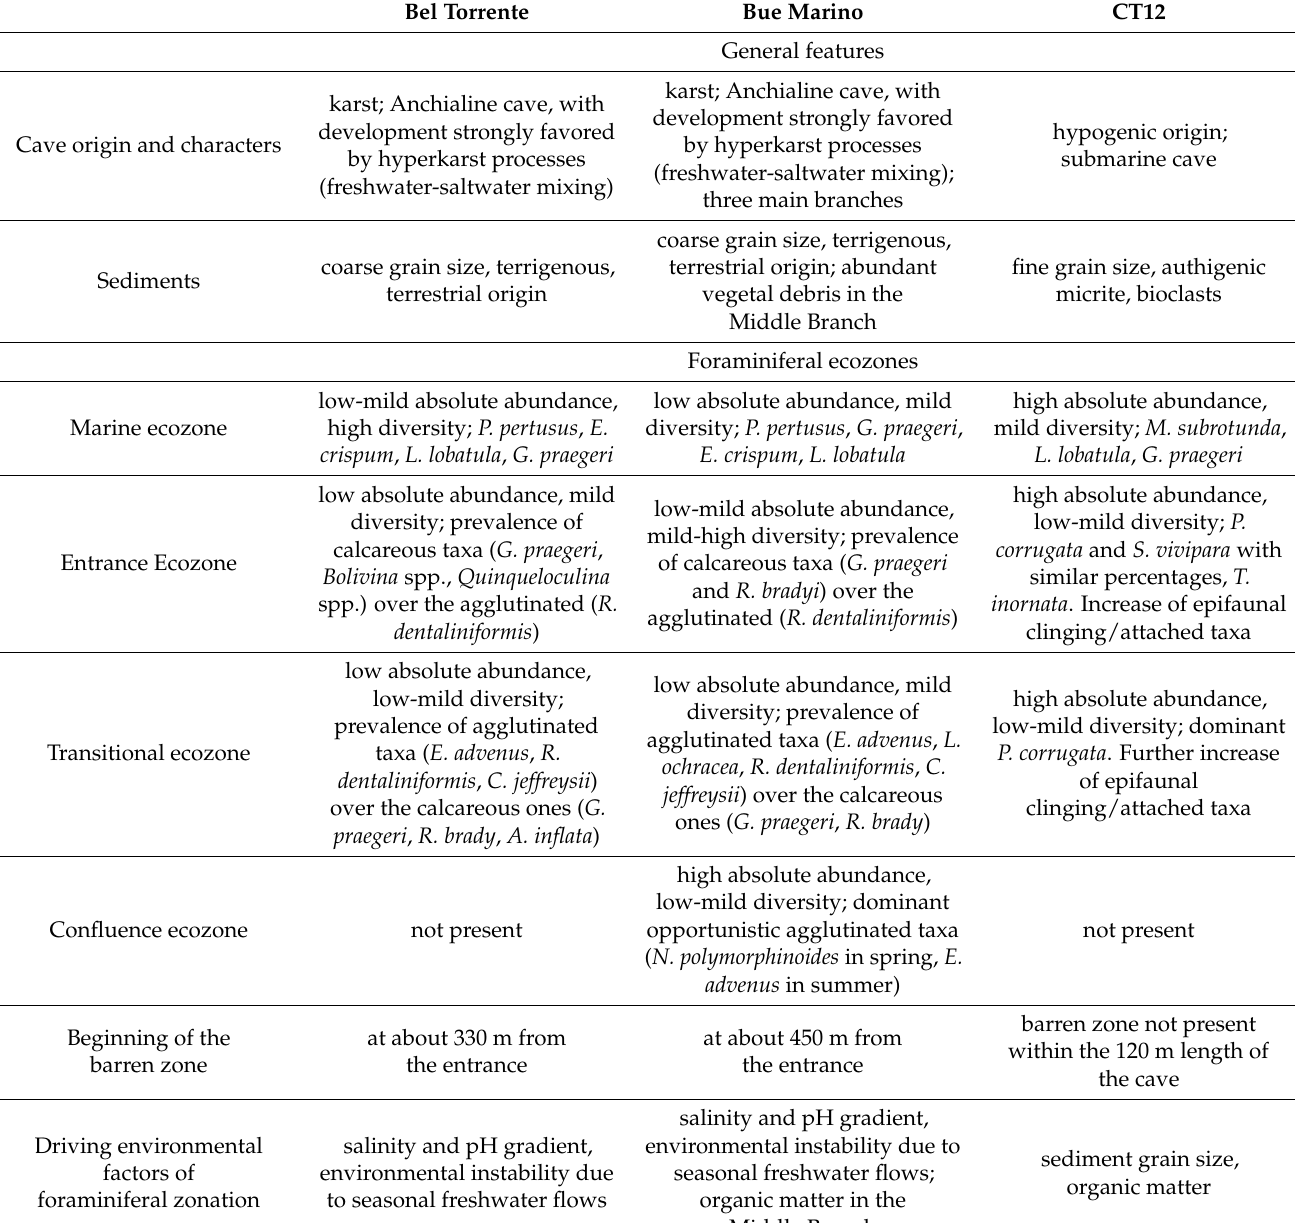
Table 1. Mediterranean caves with the main features of foraminiferal